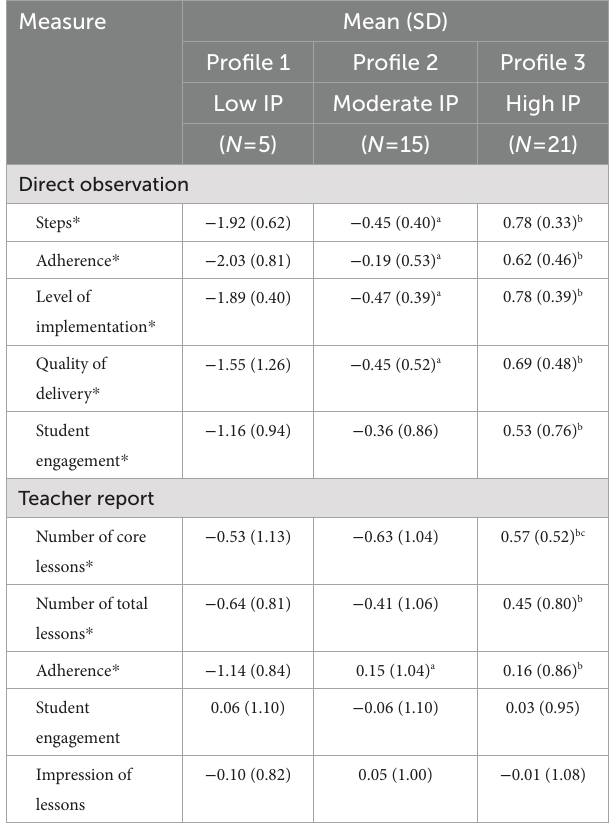
TABLE 3 Descriptive statistics of the implementation scores by